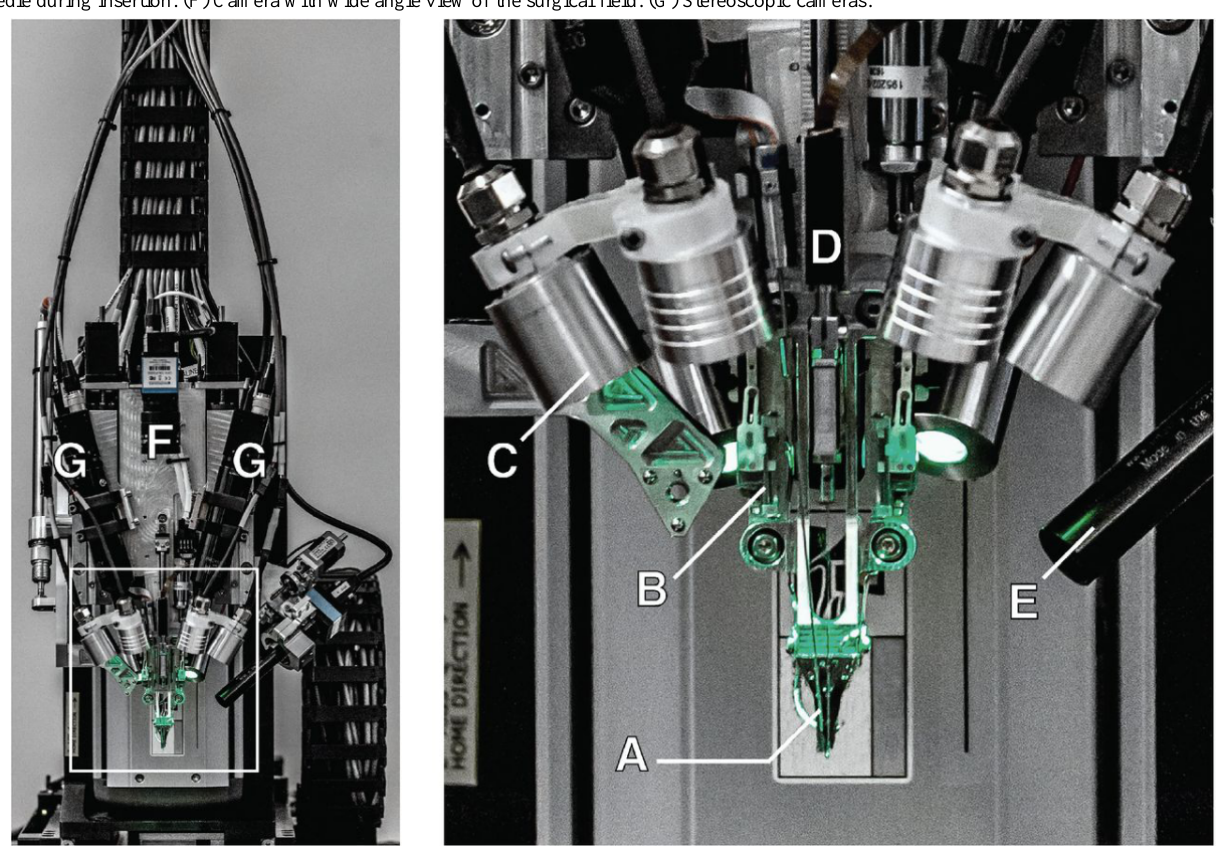
Figure 4. The robotic electrode inserter; enlarged view of the inserter-head shown in the inset. (A) Loaded needle pincher cartridge. (B) Low-force contact brain position sensor. (C) Light modules with multiple independent wavelengths. (D) Needle motor. (E) One of four cameras focused on the needle during insertion. (F) Camera with wide angle view of the surgical field. (G) Stereoscopic